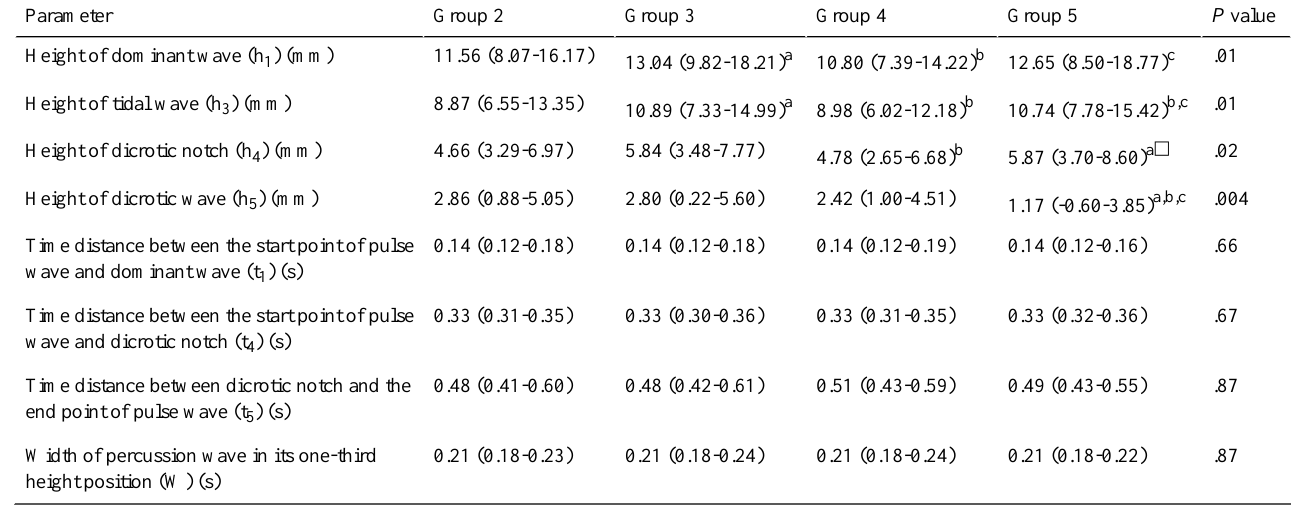
Table 4. Comparison of pulse wave parameters between groups 2, 3, 4, and